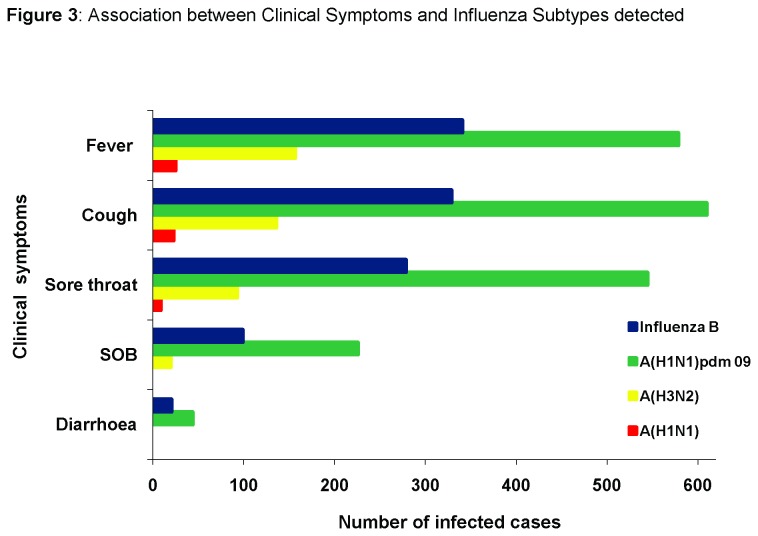
Association between Clinical Symptoms and Influenza Subtypes detected.Comparison of clinical symptom like fever, cough, sore throat and shortness of breath with influenza types and subtypes.